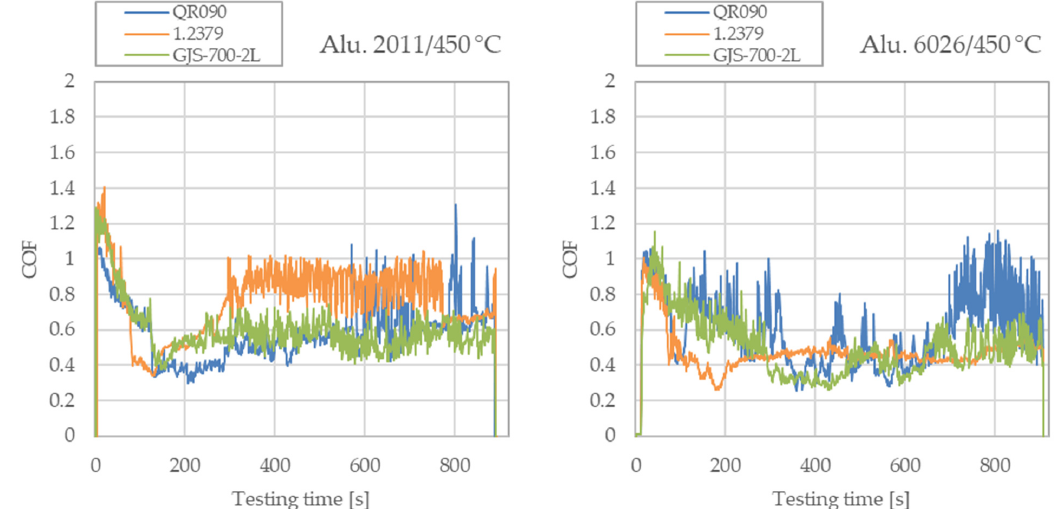
Figure 4. COF evolution for each tool material–aluminium alloy combination. The graphs have been grouped per testing temperature.